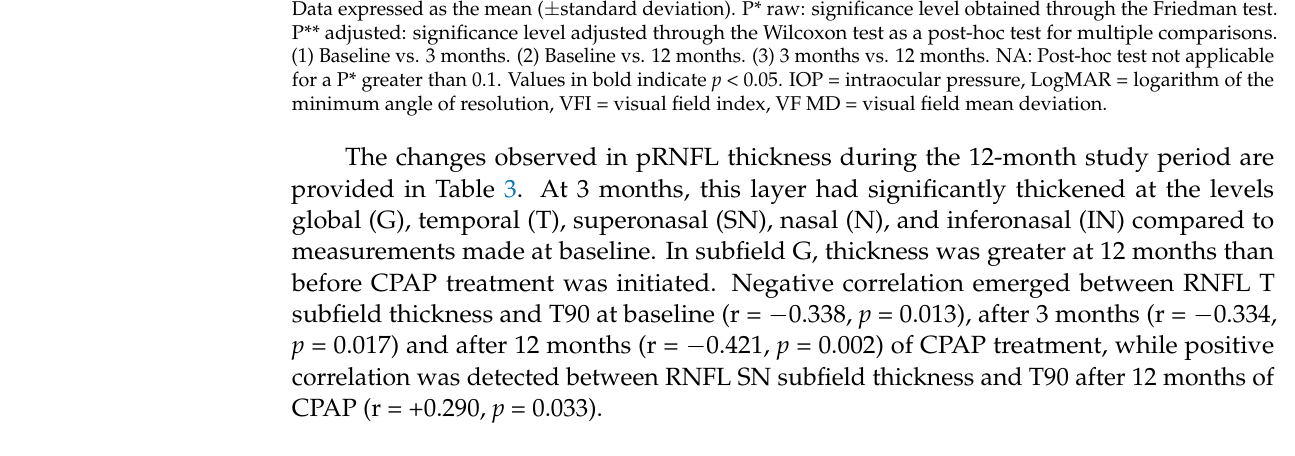
Table 3. Retinal nerve fiber layer thickness at the peripapillary level recorded at baseline and at 3 and 12 months of follow up in patients with obstructive sleep apnea undergoing continuous positive airway pressure